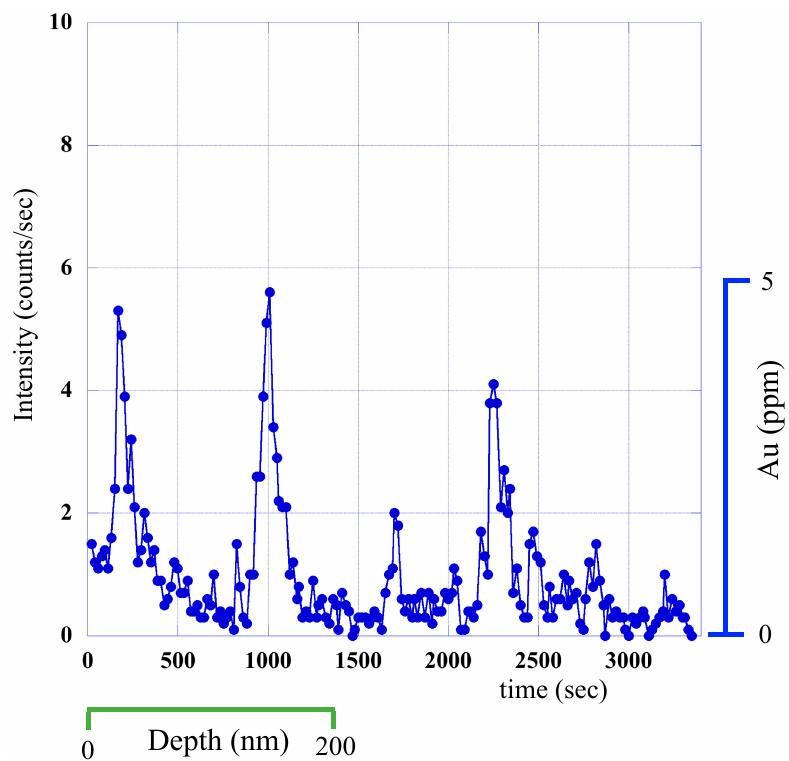
Figure A2. Depth profile of Au concentration in pyrrhotite (34S_Au4*105.adp in Table A1) from the Kalahari Goldridge deposit. Several peaks corresponding to Au NPs are present in the profile.